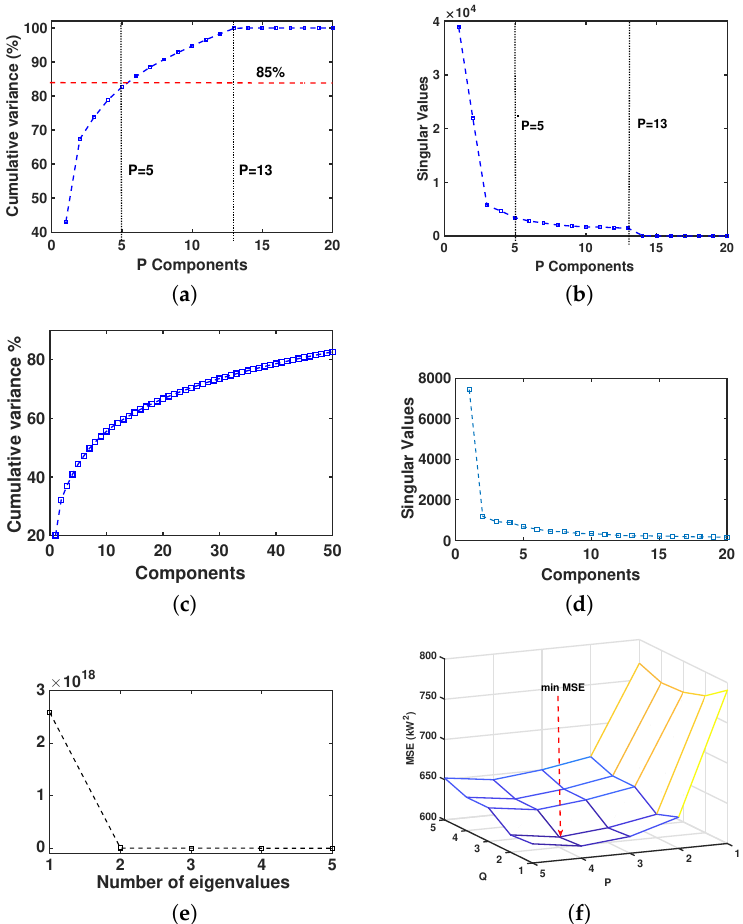
Figure 2. Model parameter selection procedures: ( a ) cumulative variance contribution rate for principal component analysis (PCA) model for Hospital Universitario de Fuenlabrada (HUF); ( b ) singular values from PCA model in HUF; ( c , d ) the same for Centro de Especialidades El Arroyo (CEA); ( e ) eigenvalue decomposition from orthonormal partial least squares (OPLS) in the HUF case; ( f ) grid search of hyperparameters in the HUF